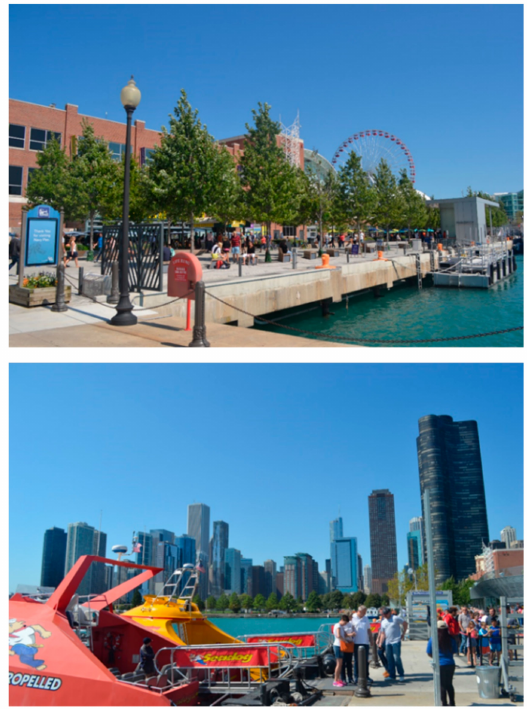
Figure 8. Navy Pier is a 3000-foot-long pier entertainment district. Study participants liked the great variety of shops, amusement, and recreational areas supplied by this 50-acre pier. They also enjoyed taking photographs of Navy Pier while having the city skyline in the